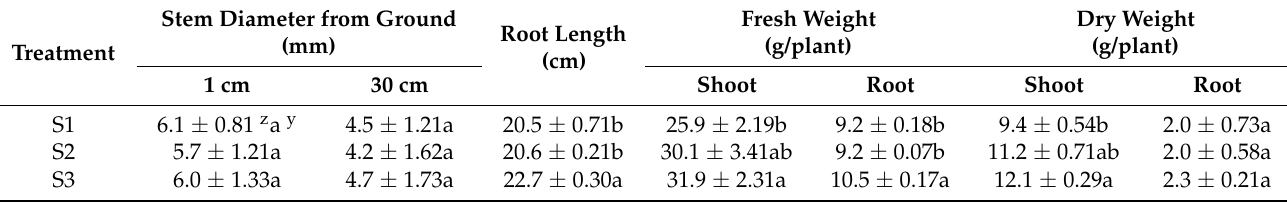
Figure 3. Effect of substrate composition on plant height ( A ), leaf number ( B ), leaf area ( C ) and node number ( D ) of M-9 apple rootstock plant at 11 weeks after treatment in a greenhouse. S1, S2 and S3 indicate 1:1:1, 1:2:3, and 3:1:2 ratio of peat moss: vermiculite: perlite, respectively. Lines above the bar represent the standard error of the mean ( n = 5). Means above each bar followed by the same letters are not significantly different with Duncan’s multiple range test (DMRT) at p ≤ 0.05. Table 1. Effect of substrate composition on stem diameter, root length, fresh weight and dry weight of M-9 apple rootstock plants at 11 weeks after treatment. S1, S2 and S3 indicate 1:1:1, 1:2:3, and 3:1:2 ratio of peat moss: vermiculite: perlite, respectively.